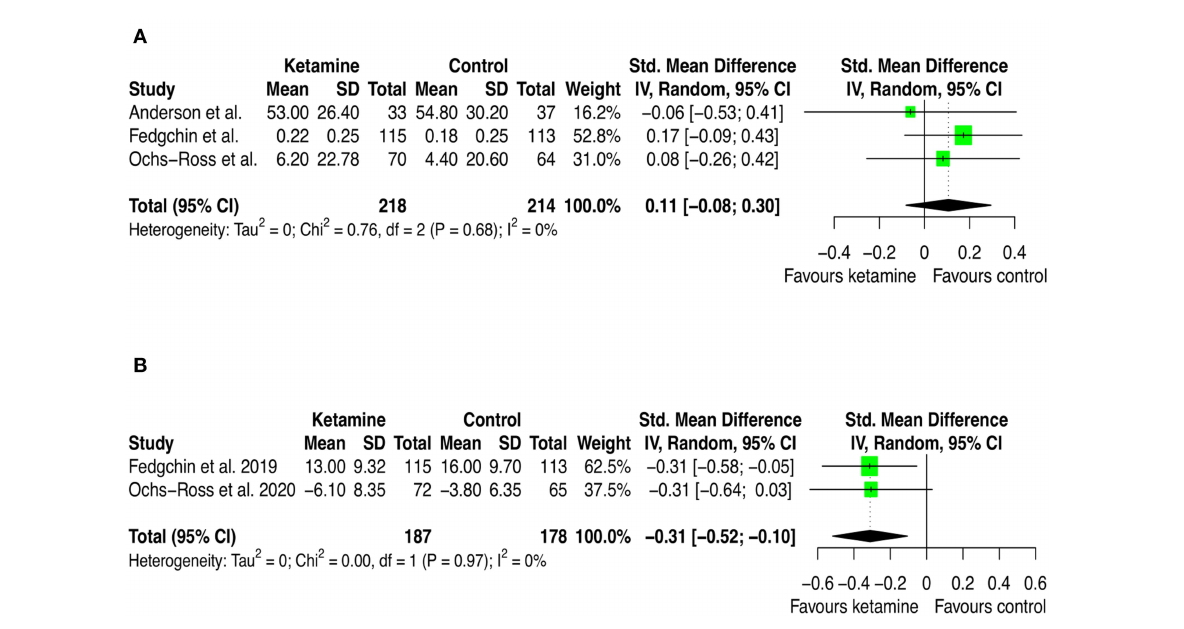
FIGURE7 Forest plots of quality of life (A) and social functioning (B) among ketamine/esketamine and control groups. SD, standard deviation; IV, inverse variance; 95% CI, 95% confidence interval. x axis labels have been edited according to the characteristics of the outcome: since lower scores indicate better status the label “Favors ketamine” is on the left-hand